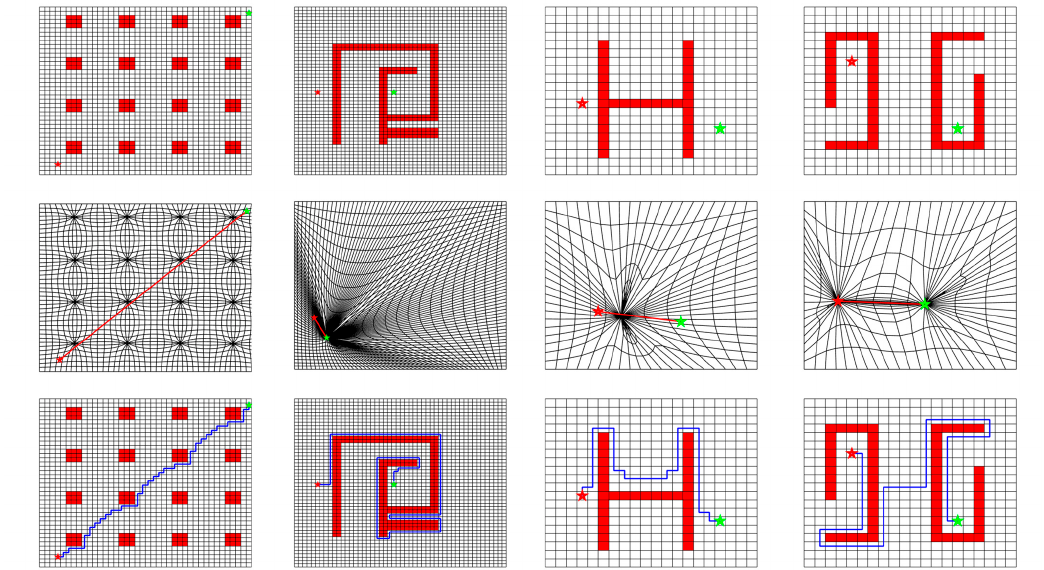
Figure 8. Some examples with floating obstacles. The first row is the initial C-space with obstacles. The second row presents the resulted DC-space after applying ACPG method. The start point (red star) and the target point (green star) are connected with one straight line directly. The third row is the generated path after projecting the path back to the